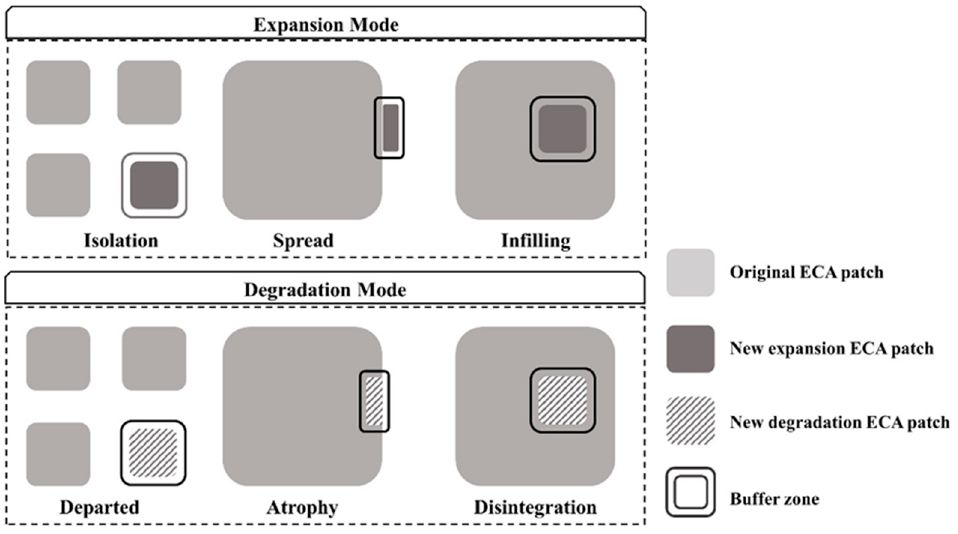
Figure 3. Graphical representation of evolution modes and specific types of ECA.